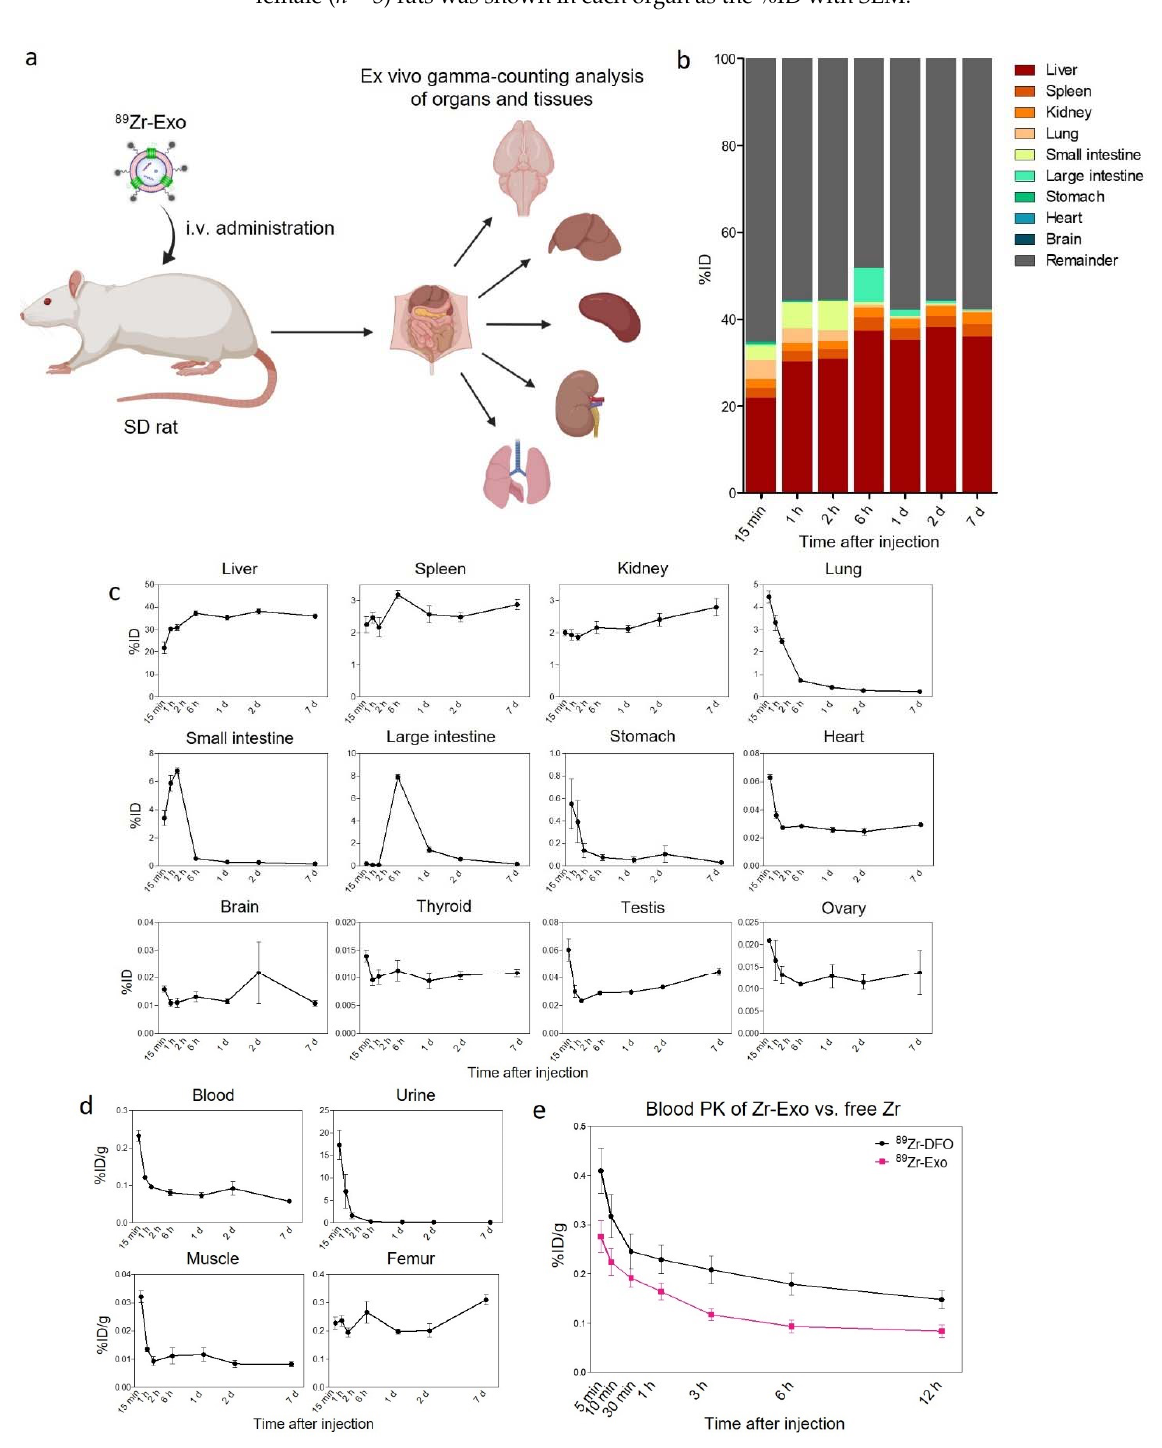
Figure 5. Biodistribution and blood PK of 89 Zr-labeled GMP-grade exosomes in rats based on ex vivo gamma-counting analysis. ( a ) Schematic of the ex vivo gamma-counting analysis of the distri- bution of i.v.-administered 89 Zr-Exo in various organs and tissues of rats. ( b ) Whole-body fraction of 89 Zr-Exo in various organs of rats ( n = 4 for each time point) was determined using a gamma- counting assay, with the results shown as the %ID at various time points. ( c ) Time-course distribu- tion of 89 Zr-Exo obtained using a gamma-counting assay in each organ was shown as the %ID with SEM. ( d ) Time-course distribution of 89 Zr-Exo in the blood, urine, muscle, and femur was shown as